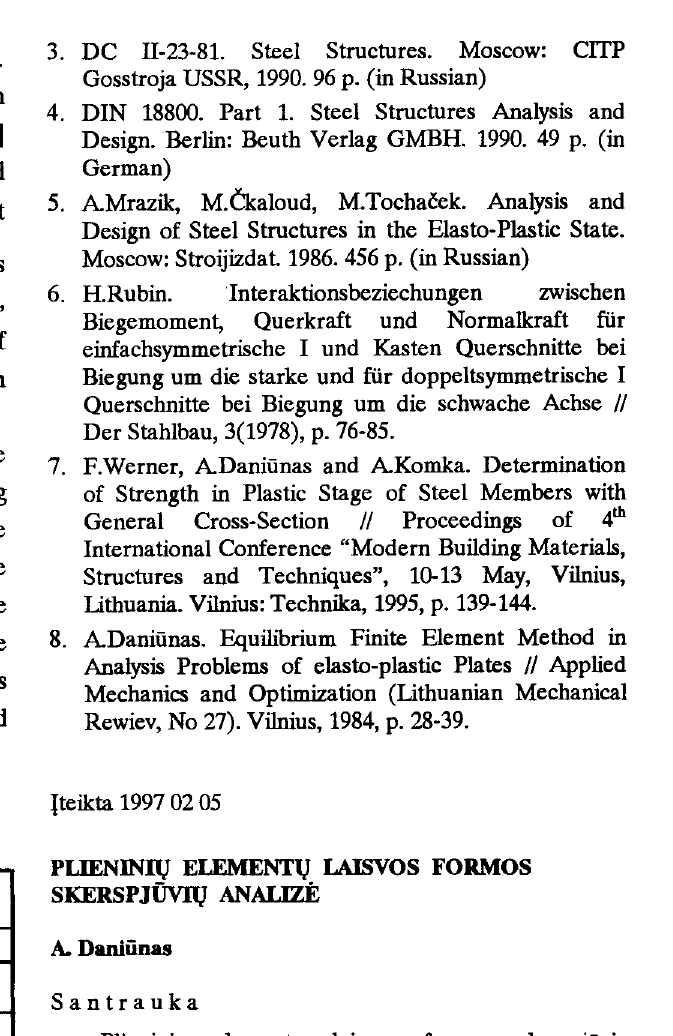
Table 1. Residual deformations &ra 10 5 at the point a Ele-